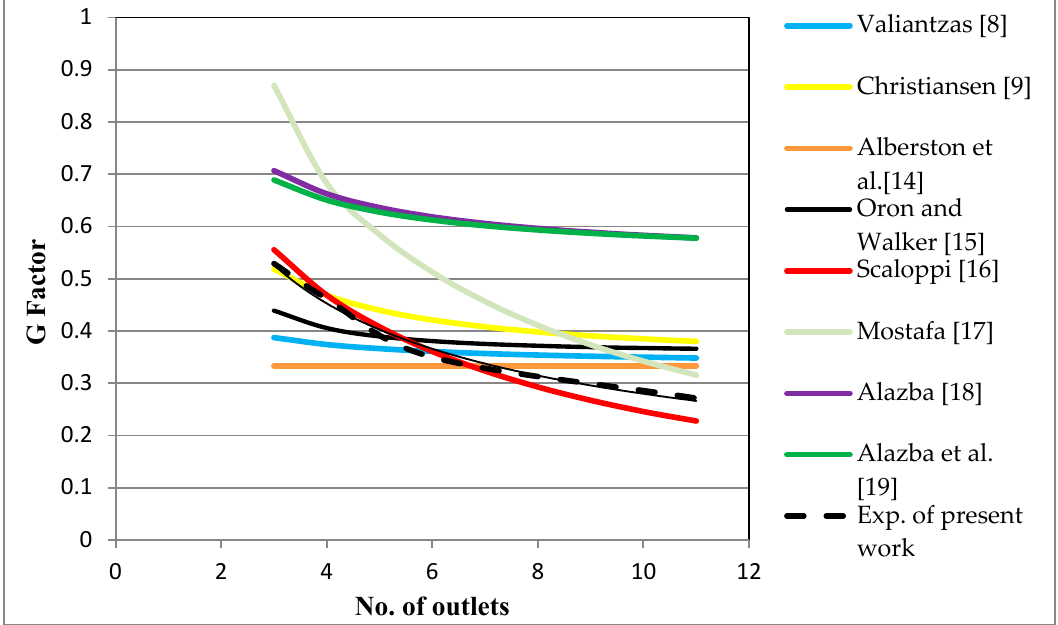
Figure 12. The variation of the G factor with the number of pipe outlets .